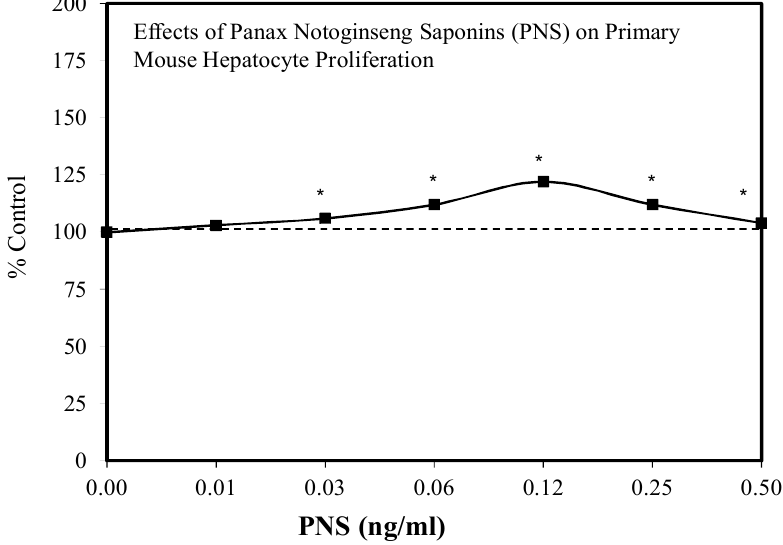
Figure 48. E ff ects of Panax Notoginseng Saponins (PNS) on primary mouse hepatocyte proliferation (source: [151]).